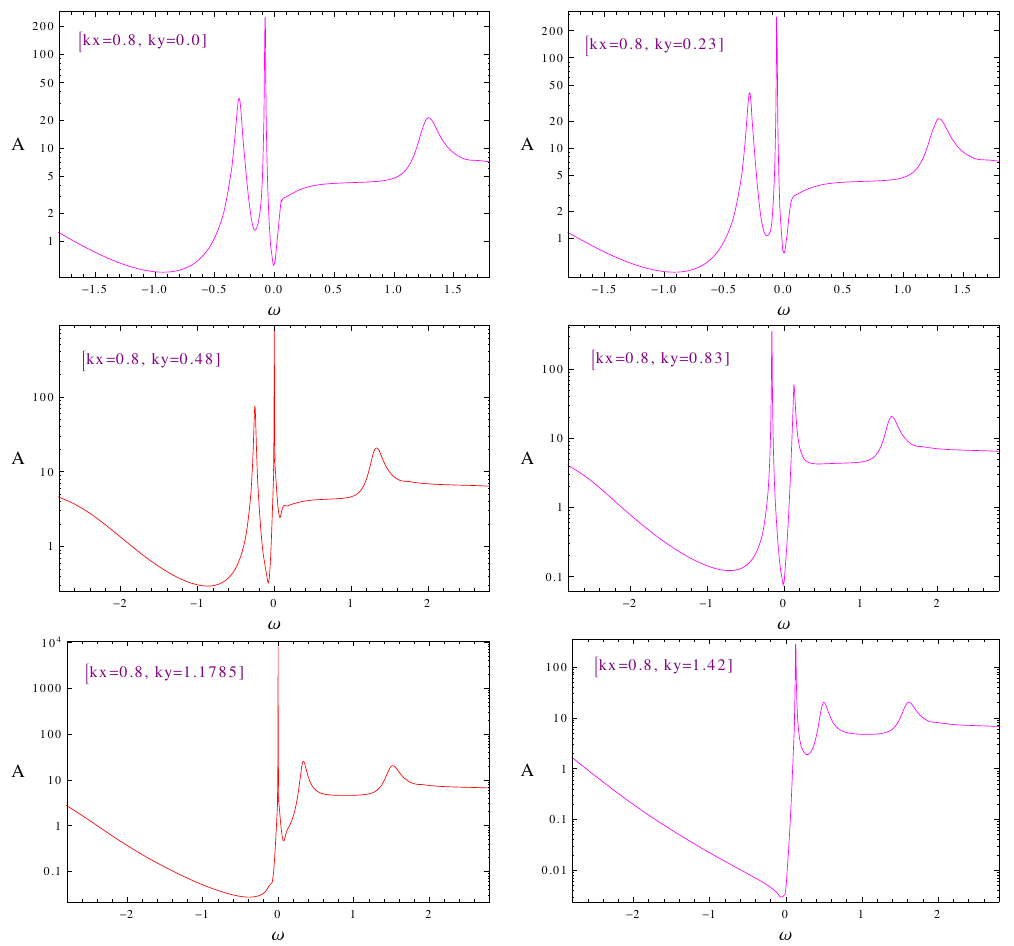
Figure 18 . The behavior of the EDF at di(cid:11)erent momenta for the PDW phase with the ionic lattice. The two plots exhibiting Fermi surfaces are marked in red. We (cid:12)x k x = 0 : 8 and increase k y from points inside the inner Fermi surface to points outside the outer Fermi surface. Note that the vertical axis is logarithmic. We have used the same setup as in (cid:12)gure 9. of the coordinate systems (3.4) ensures that the solutions are smooth near the